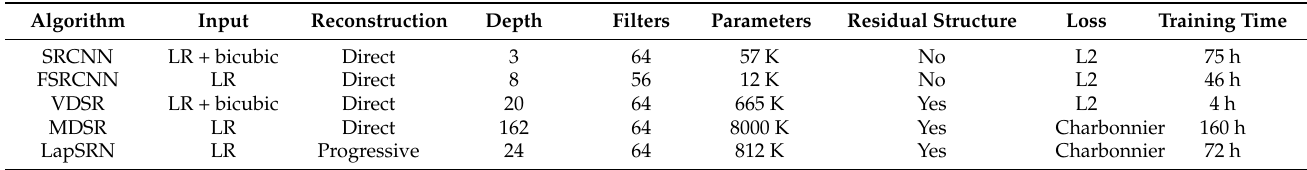
Table 1. Structural analysis of each super-resolution algorithm.